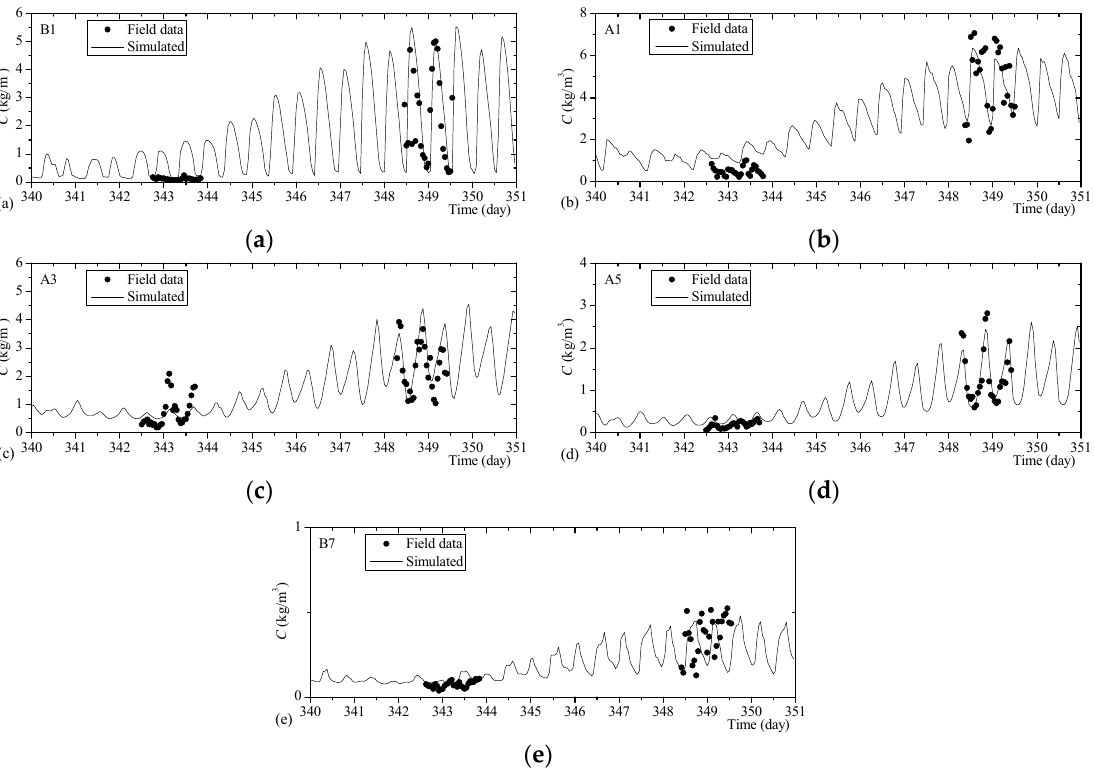
Figure 6. Comparisons of simulated sediment concentration histories and field data at survey locations. ( a ) at Survey Point B1, ( b ) at Survey Point A1, ( c ) at Survey Point A3, ( d ) at Survey Point A5, ( e ) at Survey Point B7.